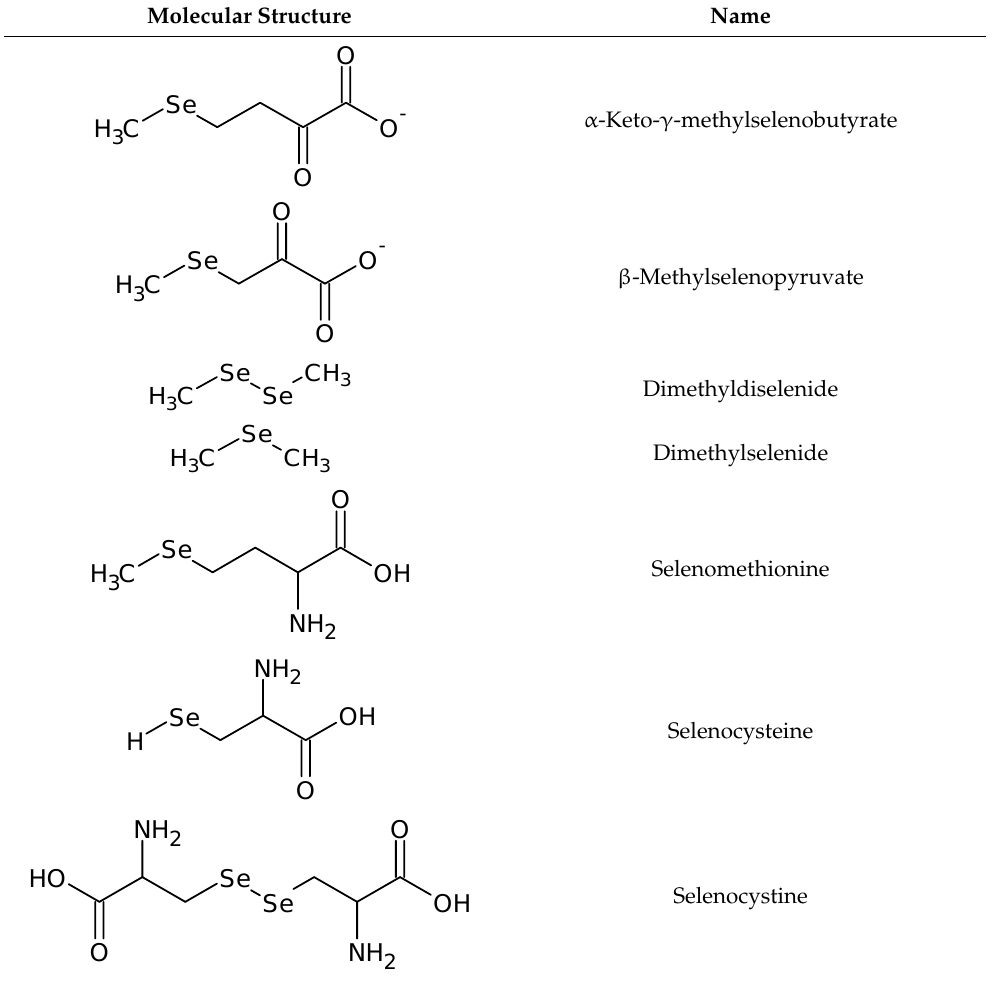
Table 1. Chemical and physical properties of selenium.